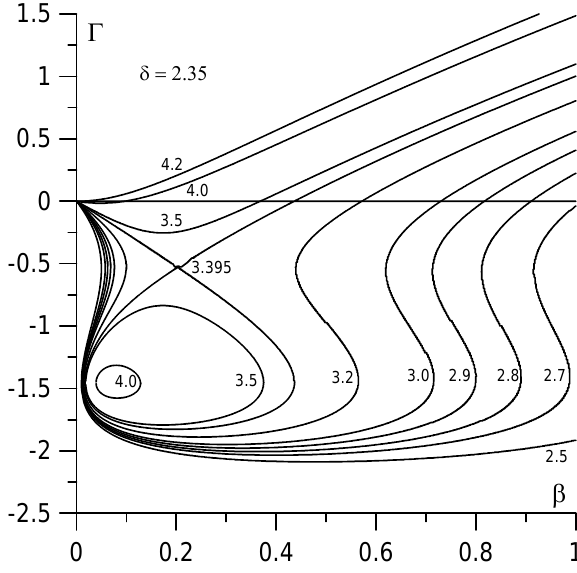
Fig. 5c. The same for δ = 2 . 35 (slightly below the δ 0 value).